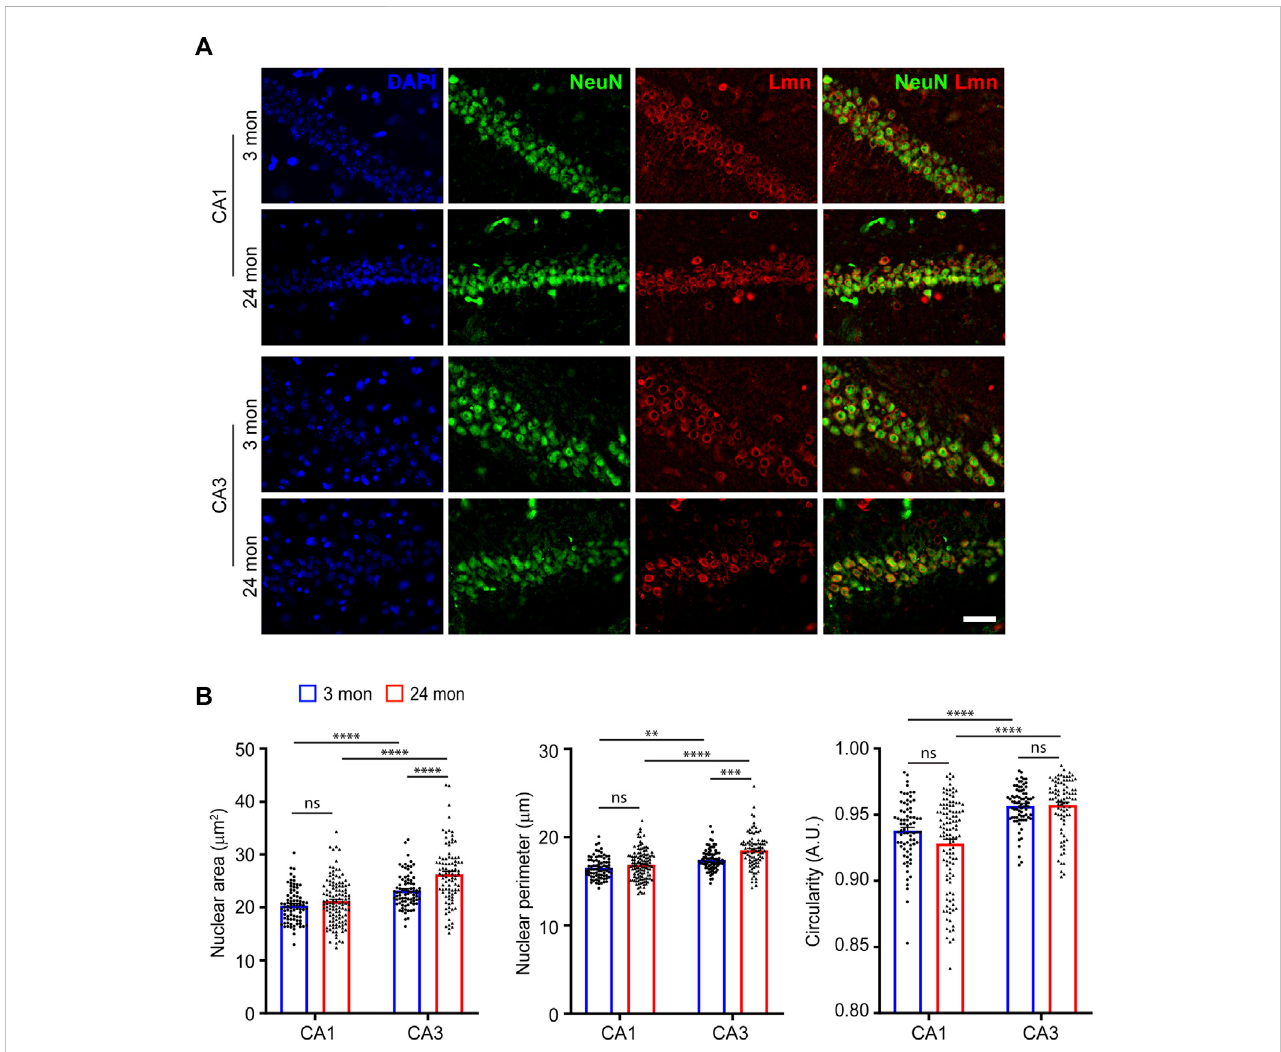
FIGURE 2 Neuronal nuclear morphology of hippocampal neurons. (A) Immunostaining of brain sections from 3-month and 24-month-old mice using anti-NeuN (green), anti-Lmn (red) along with DAPI (blue) (Scale bar, 20 µm). (B) Mean neuronal nuclear area, perimeter, and circularity in the neocortex, hippocampus (CA1 & CA3) and striatum. One-Way ANOVA (* p < 0.05, ** p < 0.01, *** p < 0.001 and **** p < 0.0001). n = 3 mice. Data represented as mean ±